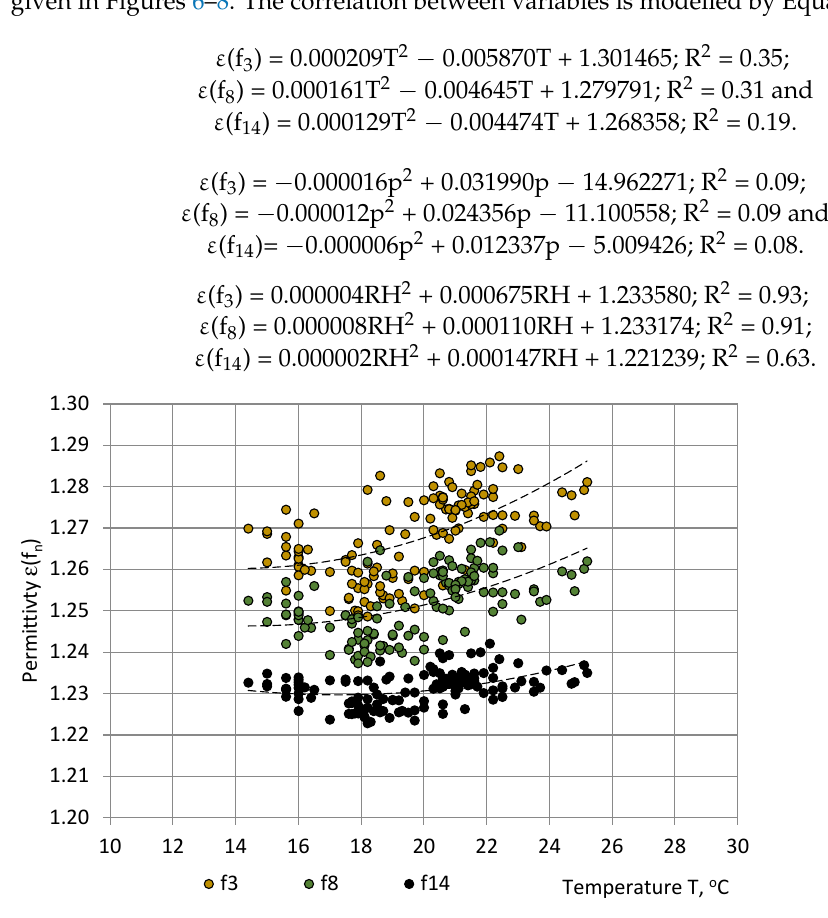
Figure 7. Correlation between the permittivity ε of PU SikaBlock ® -M150 foams (density of 144 kg/m 3 ) and the atmospheric pressure p in the test room at frequencies f 3 = 40 Hz (beige), f 8 = 1280 Hz (green), and f 14 = 81,920 Hz (black). ε (f 3 ) = − 0.000016p 2 + 0.031990p − 14.962271; R² = 0.09; ε (f 8 ) = − 0.000012p 2 + 0.024356p − 11.100558; R² = 0.09 and